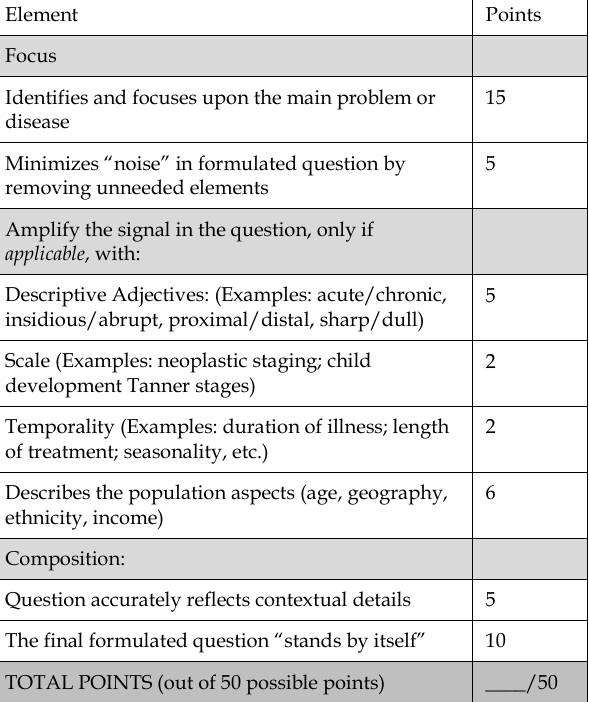
Table 2 FAC Rubric for Evaluating Formulated EBP Questions Element